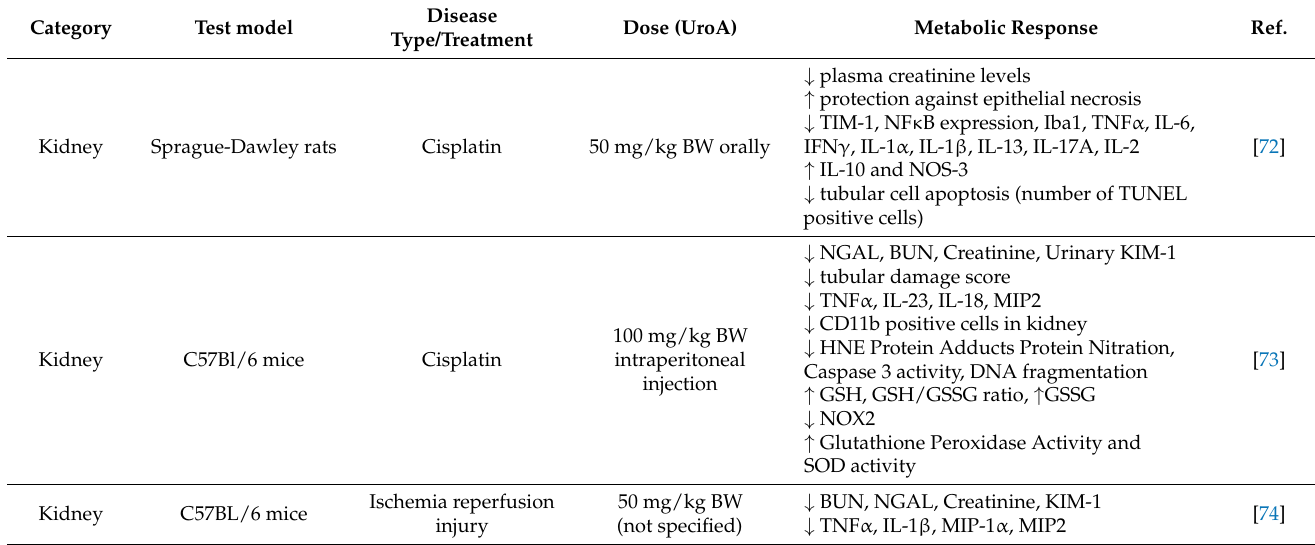
Table 3. UroA in kidney